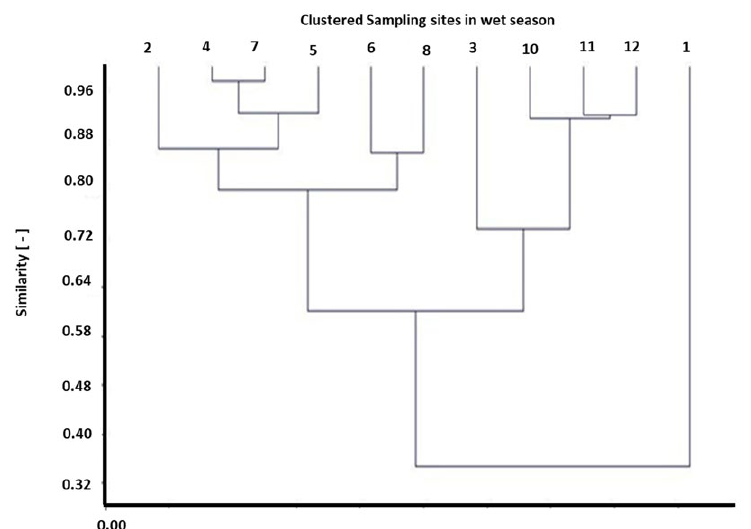
Fig 3: Cluster Dendrogram of 11 sampling sites based on the average linkage cluster analysis of macroinvertebrates in the wet season.